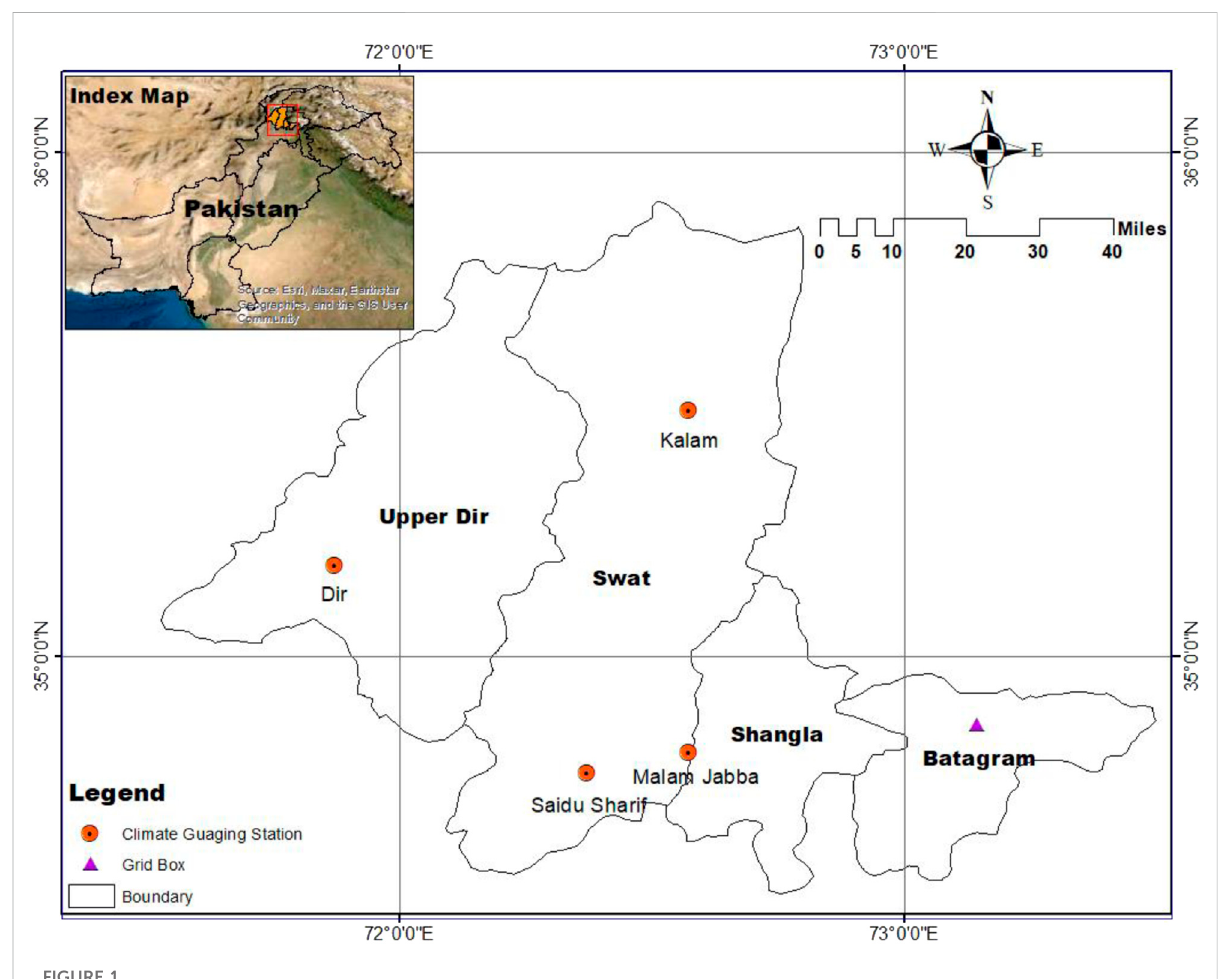
FIGURE 1 Study area map showing the weather stations used in the